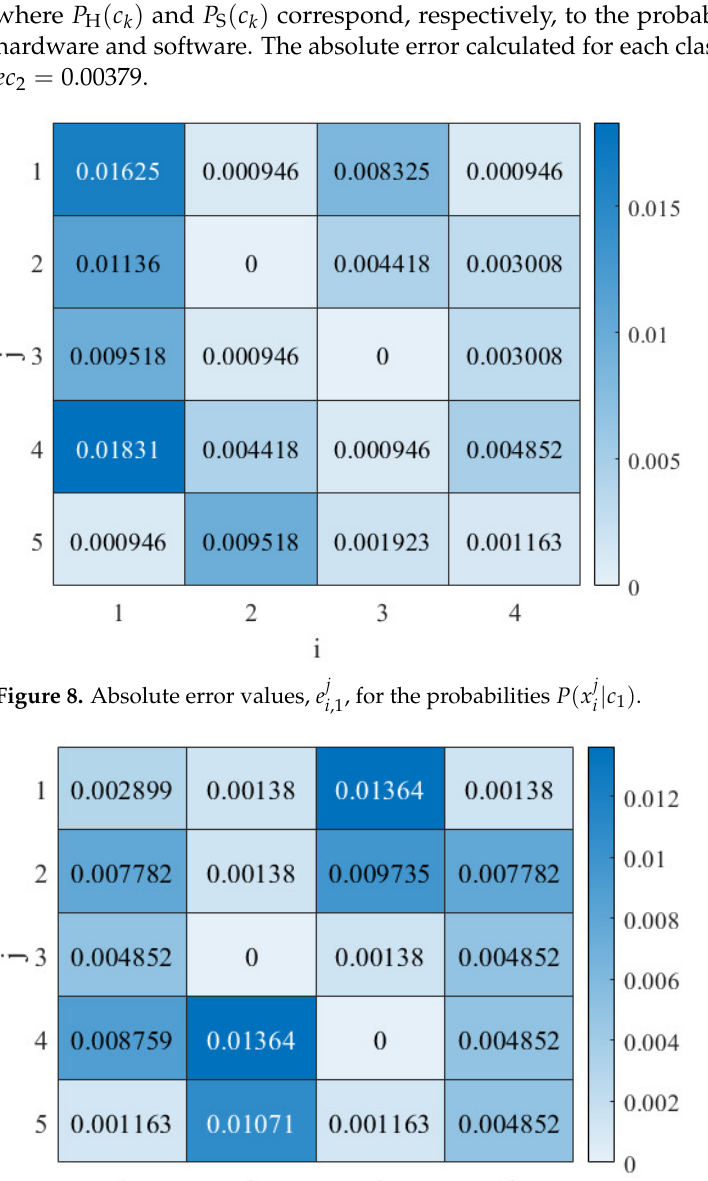
Figure 9. Absolute error values, e j